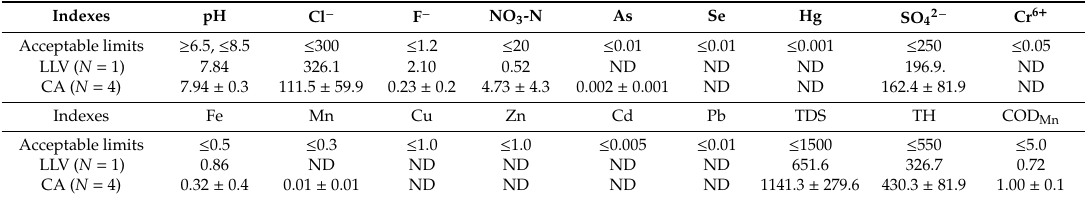
Table 4. Comparative statistical analysis of the mean values ± standard deviations of inorganic components in drinking water (mg / L, except pH